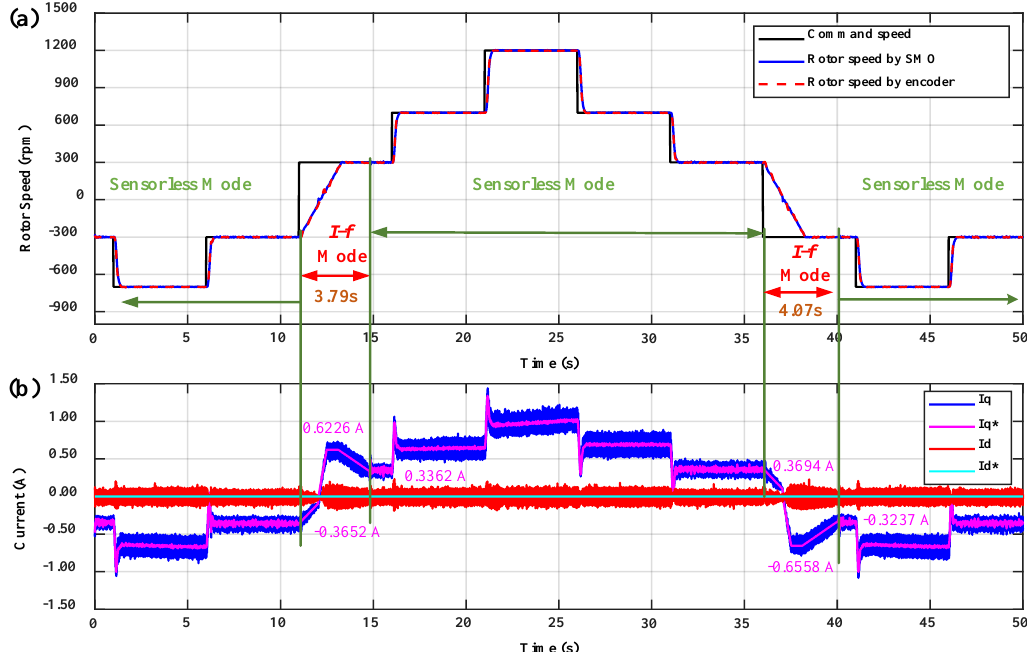
Figure 18. Experimental results in the case of the varied rotational direction for: ( a ) speed response; and ( b ) current response.